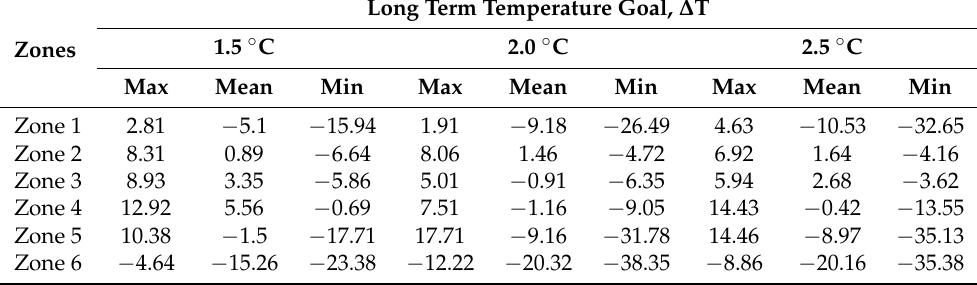
Table 5. Ensemble maximum, minimum, and mean percentage change in annual precipitation (%) over the six sub-regions of the Caribbean for the three global warming thresholds. Changes are with respect to a 1960–1990